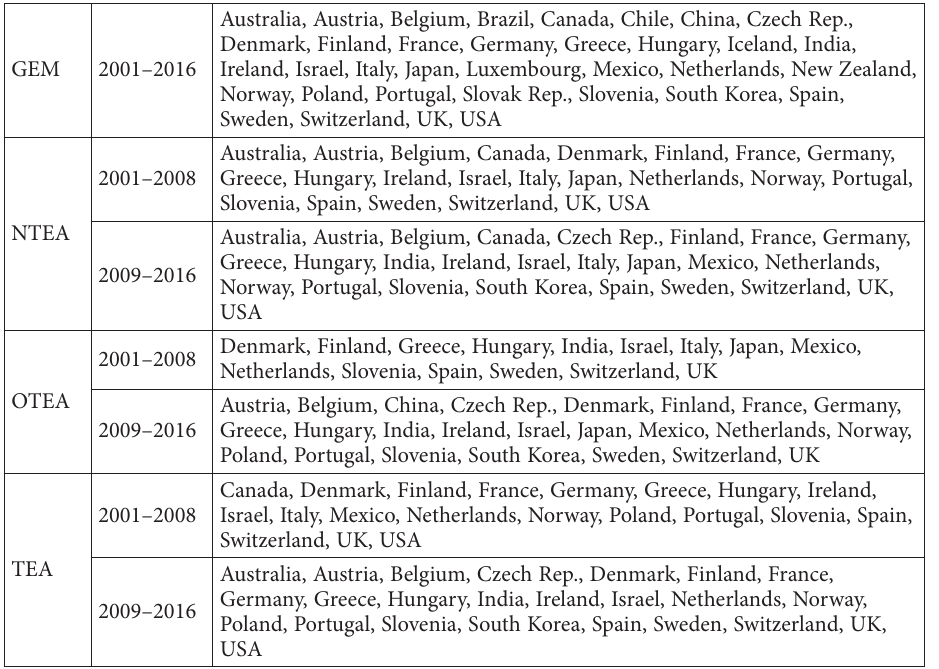
Table 1. Countries considered for each of the exploratory models